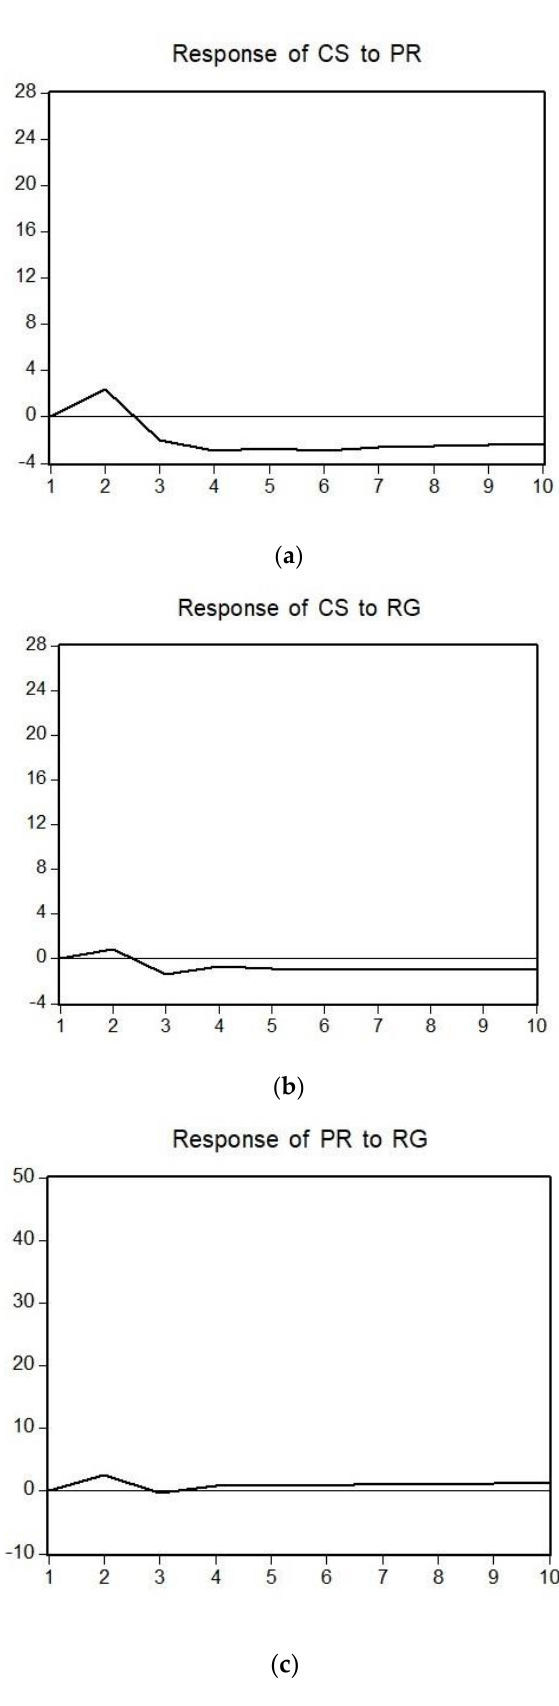
Figure 2. Response to impulse of the variables analyzed over a 10-year period.